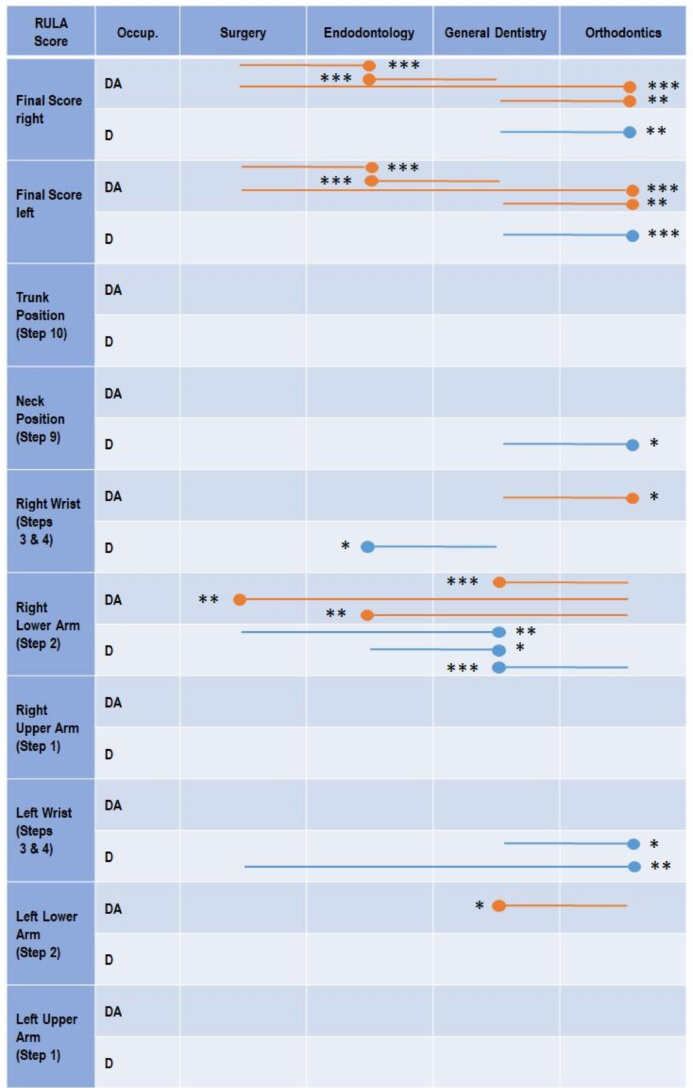
Figure 3. Significant differences in the relative average risk score over the time between the four special- izations for DAs (orange lines) and Ds (blue lines) in the outcomes of final score right and left; trunk score , neck score , wrist score right and left; lower arm score right and left; and upper arm score right and left. The lines indicate the comparisons calculated (e.g., general dentistry—orthodontics). The circle marks the field of specialization with the significantly lower (better) ergonomic risk score, while the asterisks indicate the statistical significance (* p < 0.05; ** p < 0.01; *** p <